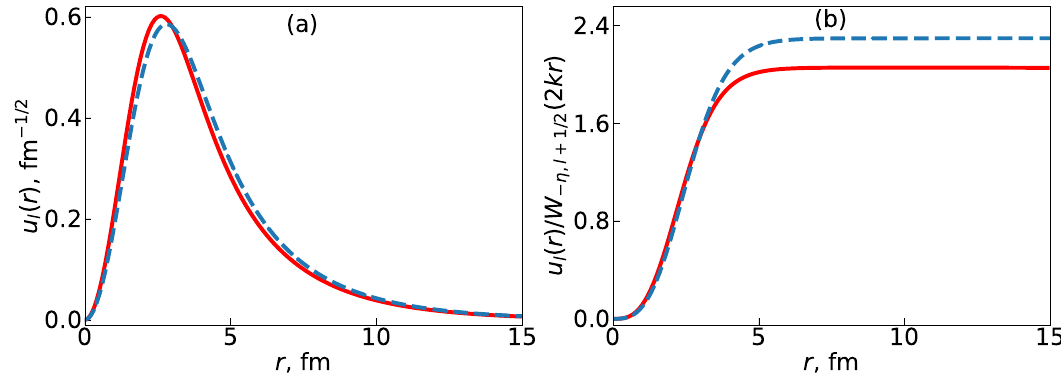
Figure 2: The proton ground state 1 p wave function for p + 12 C (a) and its ratio 1 / 2 to the Whittaker function (b) obtained using local (solid curves) and the Perey-Buck potential (dashed